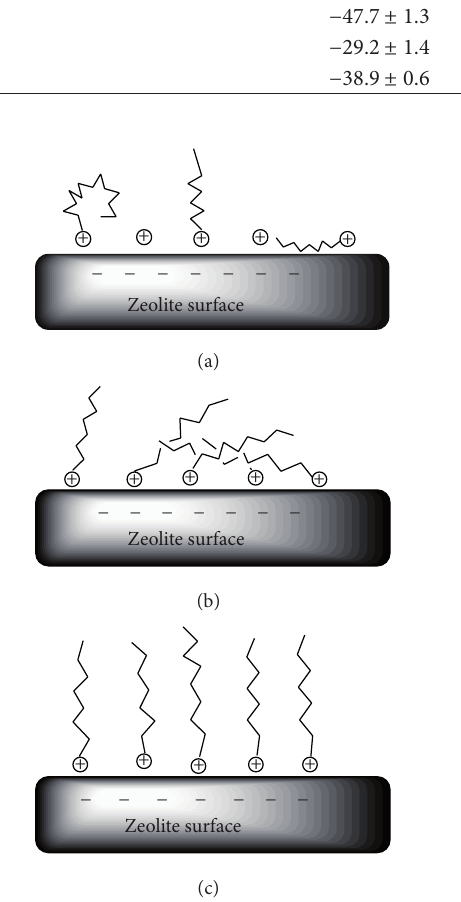
F 5: Various orientations of surfactant molecules on zeolite surface zeolite surface (a) lower coverage monolayer, (b) midcov- erage monolayer, and (c) higher coverage